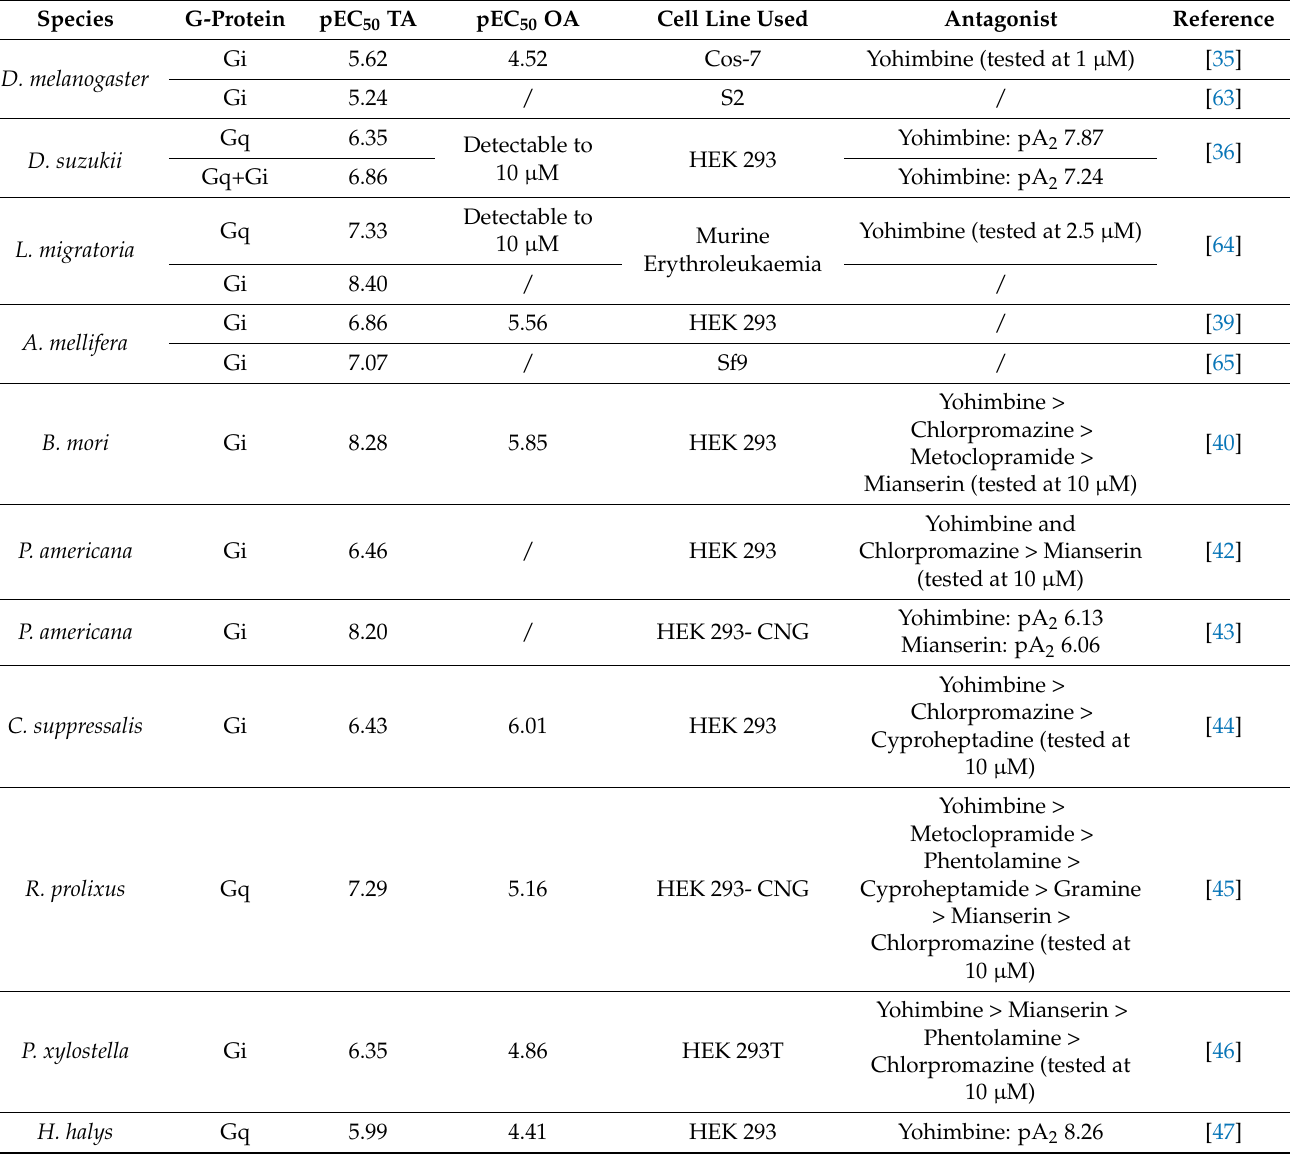
Table 2. Functional and pharmacological properties of TAR1s cloned from insects.